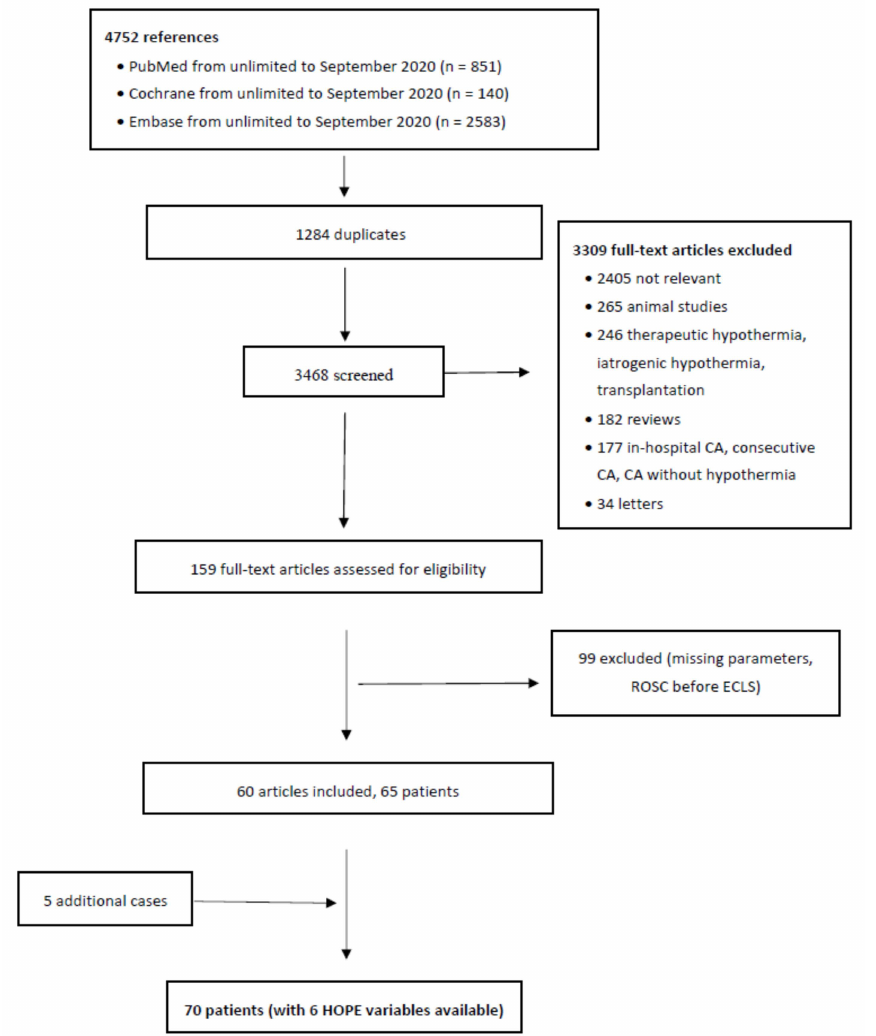
Figure 1. Flow chart for patient selection in the systematic review of patients with